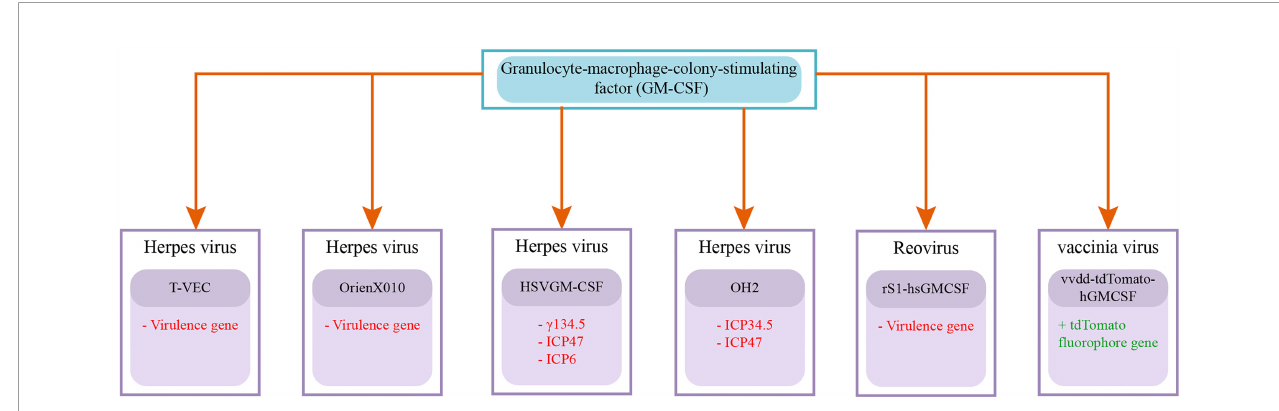
FIGURE 3 | Recombinant Oncolytic Viruses armed with GM-CSF gene: GM-CSF is signi fi cant in oncolytic immunotherapy as its overexpression is associated with suppressing tumor growth (243). Talimogene laherparepvec (T-VEC) and OrienX010 are herpes simplex viruses that are genetically modi fi ed to omit and incorporate virulence and GM-CSF genes, respectively (160). HSVGM-CSF is also an oncolytic herpes simplex virus that is genetically altered to delete g 134.5, ICP47, and ICP6, and express GM-CSF genes for improving antitumor response (169). OH2 (oncolytic herpes simplex virus 2) is generated to express GM-CSF transgene with deleted ICP34.5 and ICP47 genes expressions for improved tumor selective replication (244). A recombinant reovirus rS1-hsGMCSF was also generated for expressing the GM-CSF gene for stimulating antitumor activity (175). Vaccinia virus is also genetically altered to generate vvdd-tdTomato-hGMCSF by inserting GM-CSF and tdTomato fl uorophore transgenes for dealing with immune suppression in pancreatic cancer (201). Deleted genes are written in red color with the ( – ) sign and added genes are written in green color with the (+)